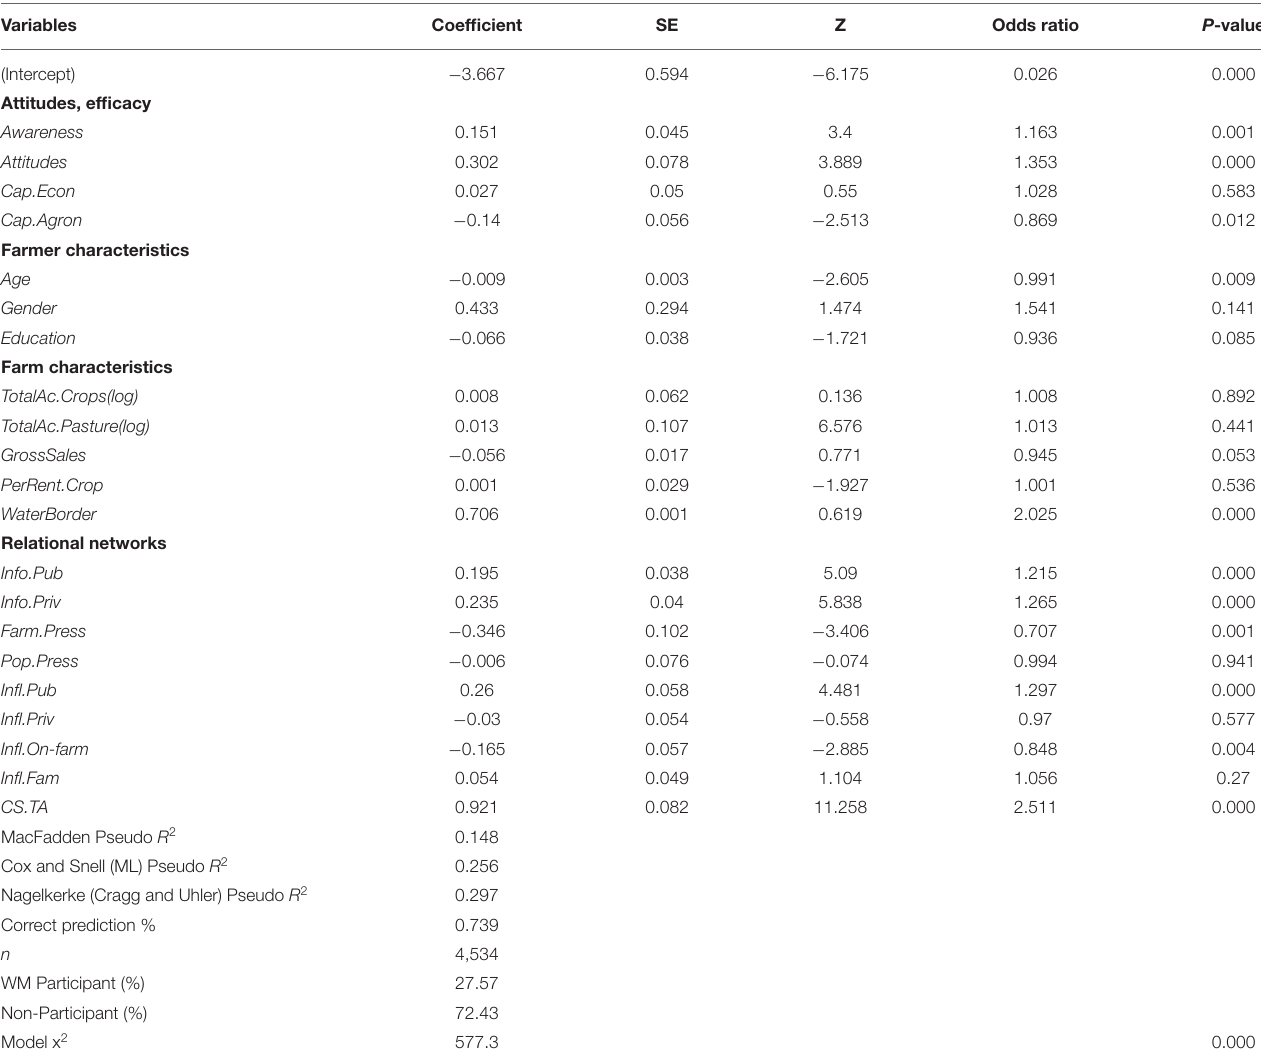
TABLE 5 | Binomial logistic regression of farmers’ participation in watershed management activities on selected variables.